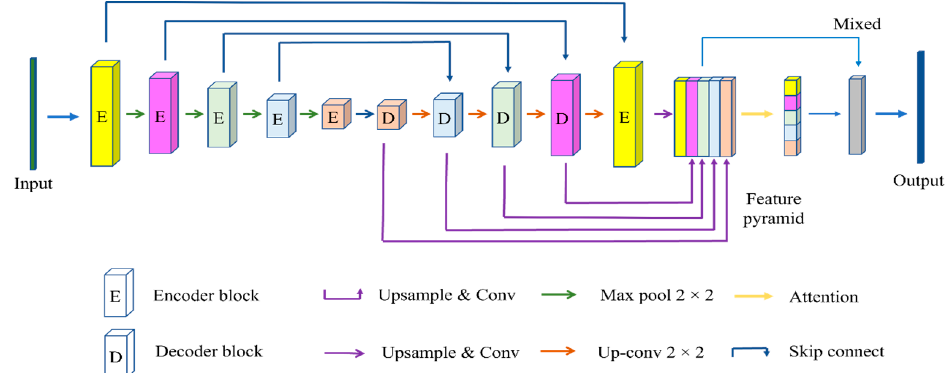
Figure 1. Diagram showing the overall structure of FPUA, where different colors indicate different sizes of feature information.